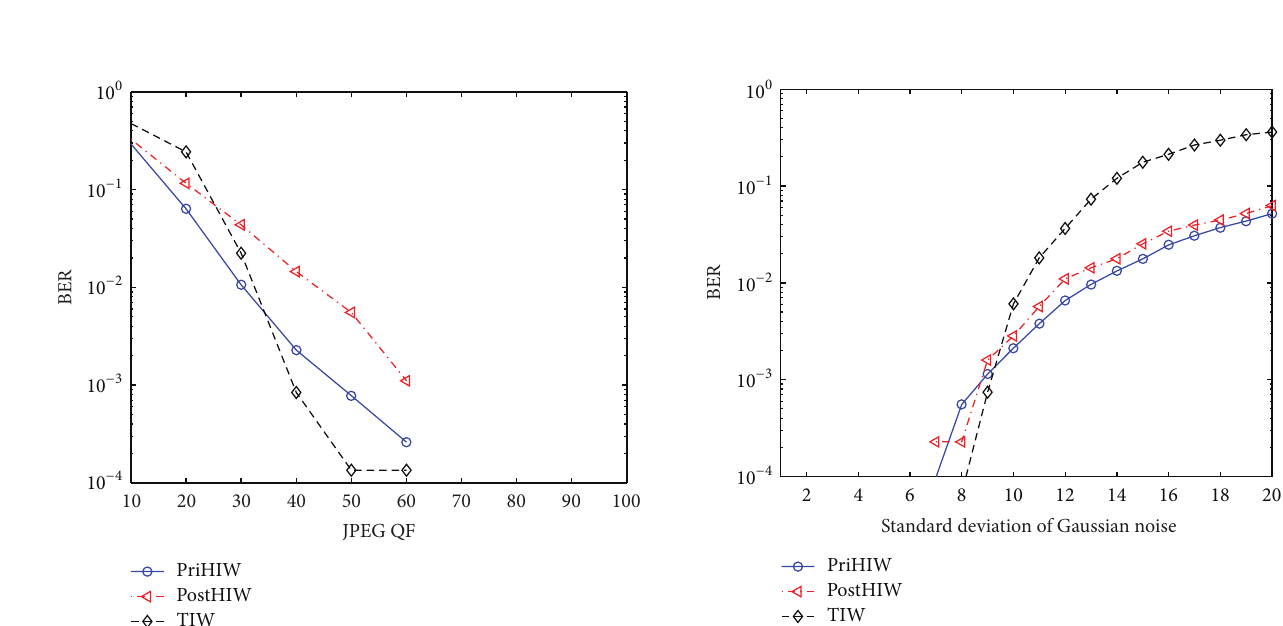
= 18.15). (c) Lena (Rbst QF = 90 , PSNR = 39.71 dB, 𝐷 Post DWT